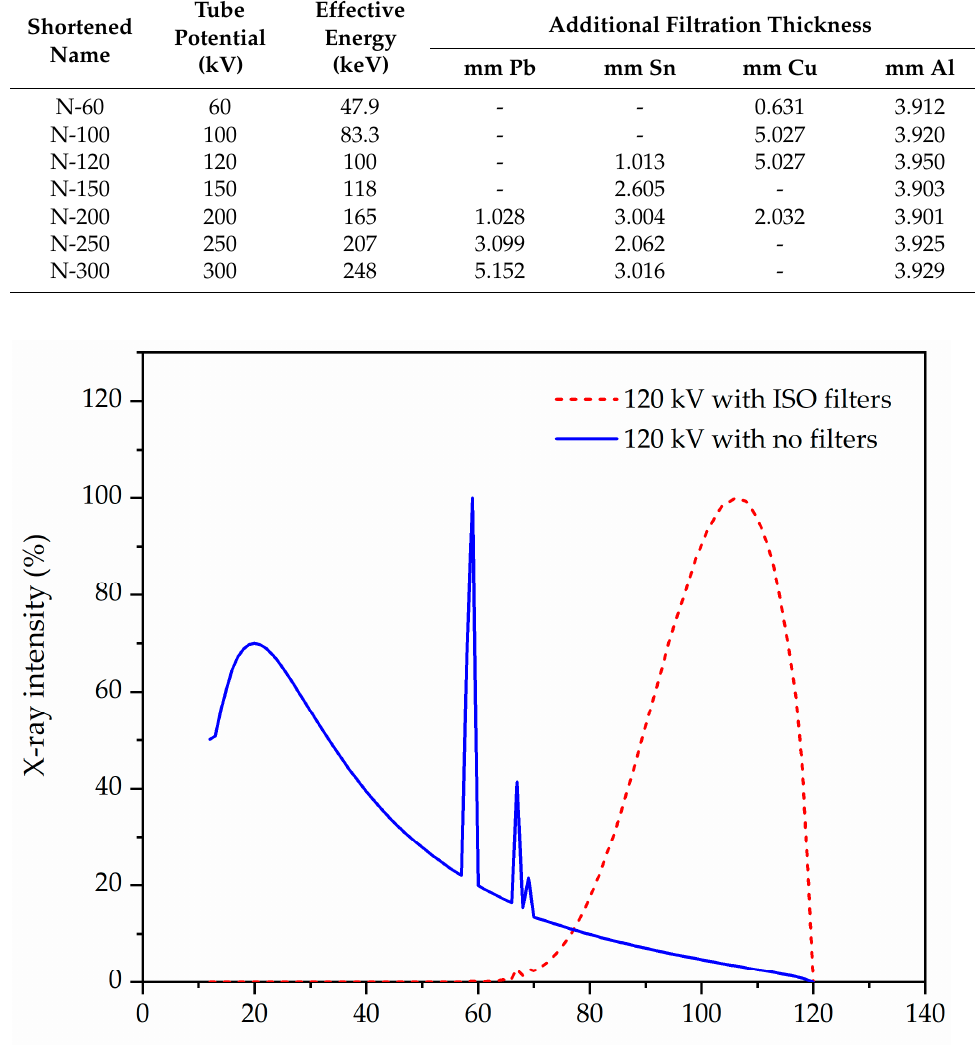
Table 6. Narrow X-ray spectrum qualities used (Adopted from ISO-4037 [42]).